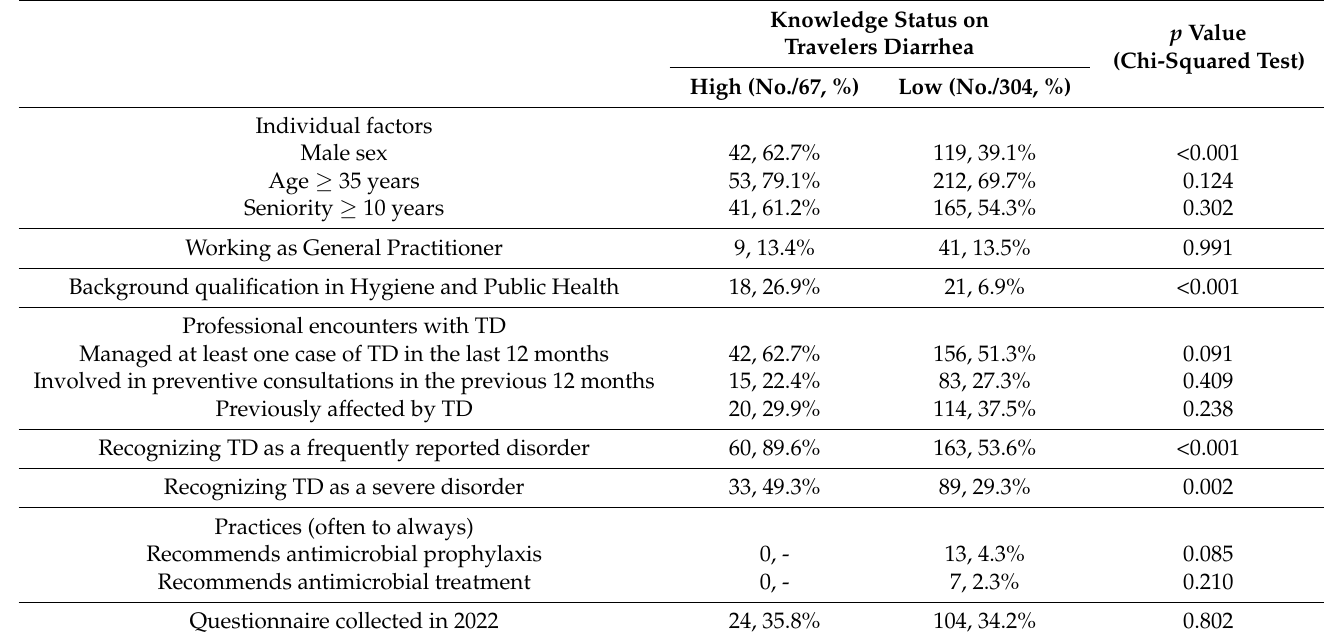
Table 3. Univariate analysis of individual factors associated with higher knowledge status (Note: TD = travelers’ diarrhea).